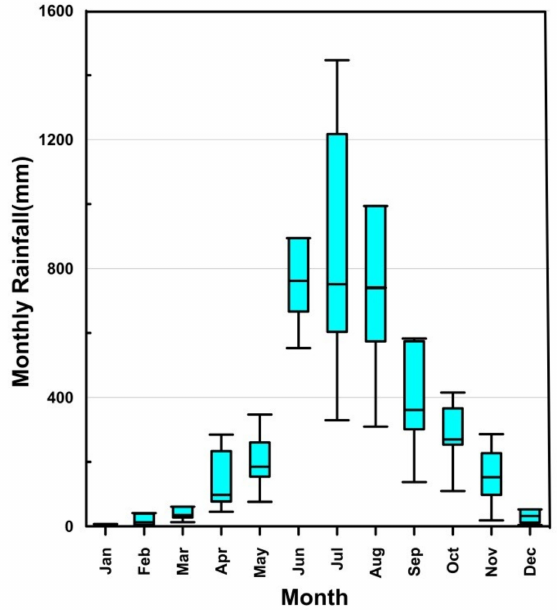
Figure 4. Box and whisker plot with monthly distributions of rainfall in the Idukki district (2010–2018). The bottom and top lines indicate minimum and maximum values respectively and the line inside the box represents the median.